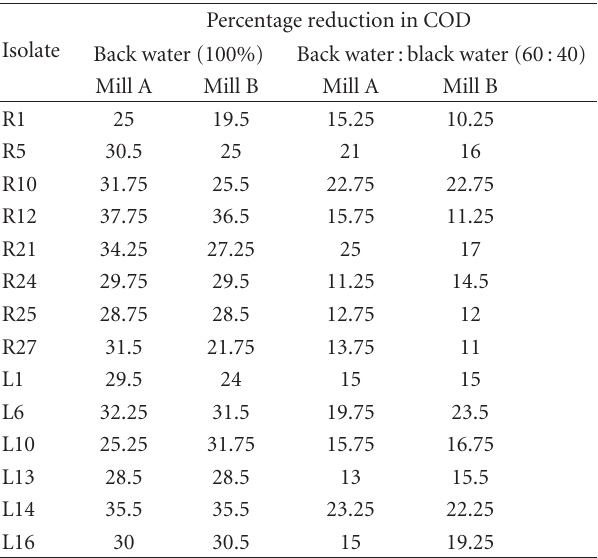
Table 3: Percentage reduction in COD of sample (back water 100%) and (back water :black liquor (60 :40)) using single isolates after 45hrs of incubation.